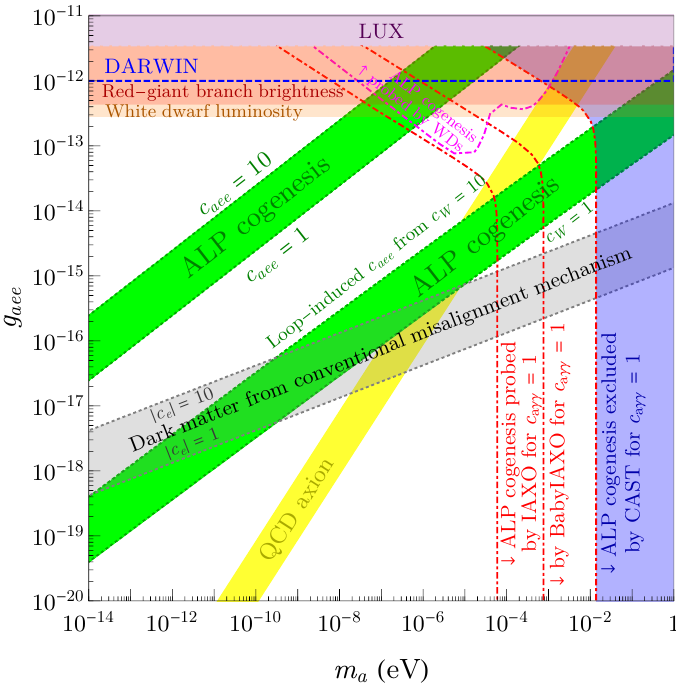
Figure 3 . The prediction on the coupling between an ALP and electrons g aee is shown for c aee = 1 (cid:0) 10 in the upper green band and for loop-induced c aee from c W = 1 (cid:0) 10 in the lower green band. The prediction of the QCD axions and of ALP dark matter from the conventional misalignment mechanism are shown in the yellow and gray bands. Other shaded regions denote the existing experimental constraints. Various curves show the sensitivity of future experiments, whereas the dot-dashed curves assume ALP cogenesis and c a(cid:13)(cid:13) =